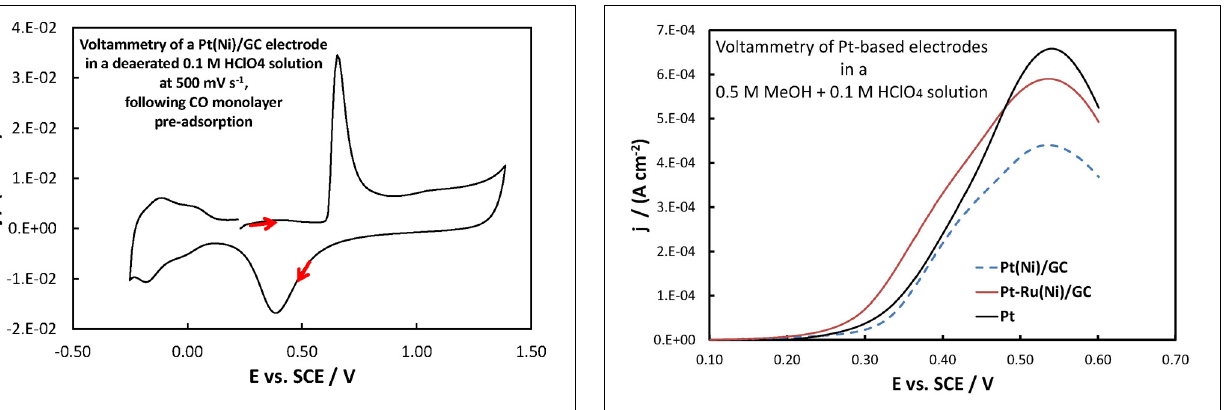
FIGURE 9 | Voltammograms (third positive-going scan at 5mV s − 1 potential scan rate) of Pt(Ni)/GC, Pt-Ru(Ni)/GC, and bulk Pt electrodes (as indicated in the graph) in a deaerated 0.5 MeOH + 0.1M HClO 4 solution. Current density is per electroactive surface